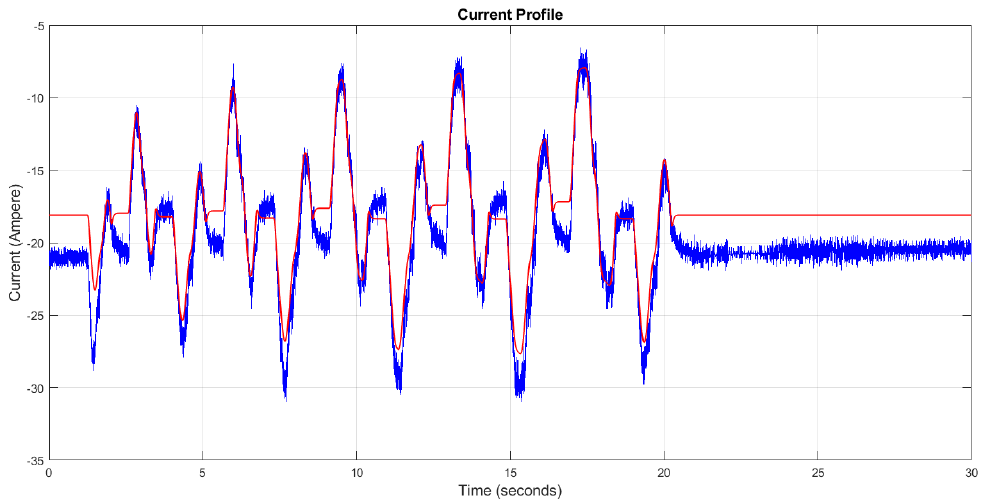
Figure 20. Real Current Profile (blue line) and Reference Current Profile (red